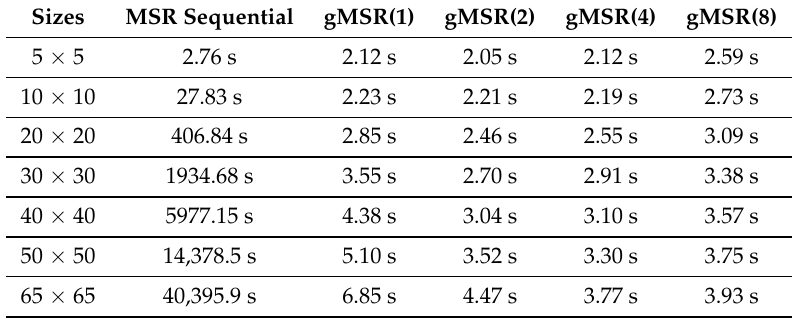
Table A2. This table shows the execution times in seconds for the processing of synthetic biclusters datasets when the size of each bicluster increases from 5 × 5 to 65 × 65 (first column). The second column corresponds to The second column corresponds to the sequential implementation of the MSR measure. The other four columns represents to the gMSR executions using 1, 2, 4 and 8 GPU devices, respectively. As it can be observed, gMSR outperforms the sequential version and scales